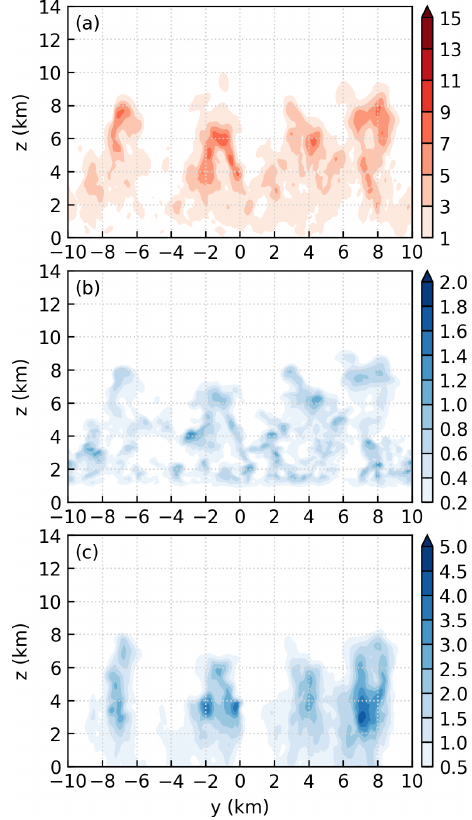
Figure 13. The same as Fig. 10 but at t = 8h 13min.